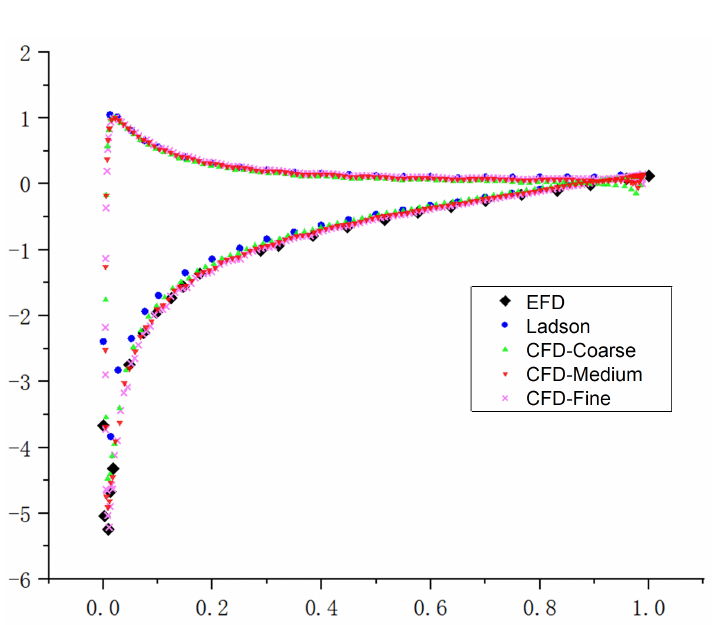
Figure 3. Influence of mesh sizing on pressure distribution on the surface of hydrofoil and comparison on experiment data at Re = 3,000,000 and AOA = 10 ◦